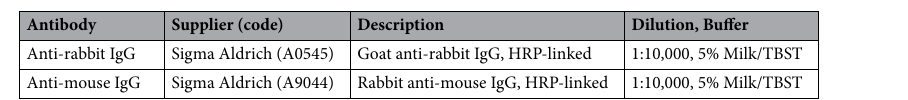
Table 2. Secondary antibodies used for western